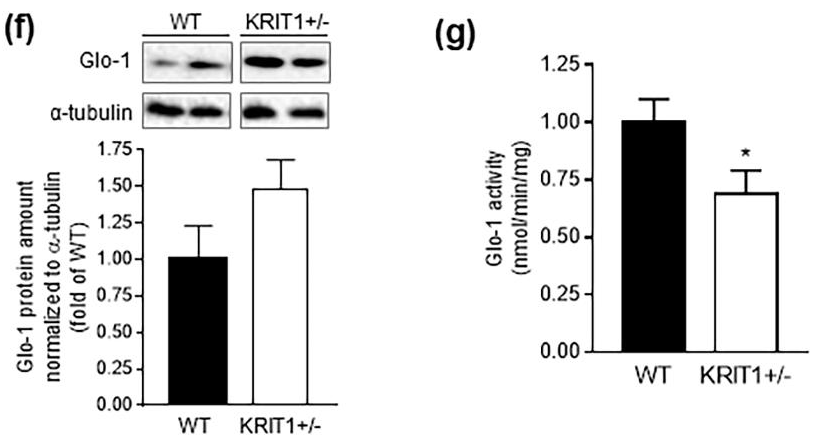
Figure 6. Heterozygous loss of KRIT1 in mice altered AGE accumulation and expression of AGE receptors and detoxifying systems in the liver. ( a , b ) Concentrations of two major types of AGEs, pentosidine ( a ) and N ε -carboxymethyl-lysine ( b ), quantified by ultraperformance liquid chromatography-tandem mass spectrometry (UPLC-MS) analysis of liver homogenates from WT and KRIT1 +/ − mice. ( c – e ) Representative Western blots showing the upregulation of pro-inflammatory AGE receptors, such as the receptor for AGE (RAGE) ( c ) and galectin-3 (Gal-3) ( d ), the downregula- tion of the anti-inflammatory receptor AGE-receptor-1 (AGE-R1) ( e ), and the upregulation of the AGE detoxifying enzyme glyoxalase-1 (Glo-1) ( f ) in the liver of KRIT1 +/ − vs. WT mice. The histograms represent the densitometric quantification of protein bands of 7 mice per group normalized to the corresponding loading control ( α -tubulin). ( g ) Enzymatic activity of Glo-1 in liver homogenates from WT and KRIT1 +/ − mice, determined spectrophotometrically by measuring the increased absorbance at 240 nm due to the catalyzed formation of S-D-lactoylglutathione from methylglyoxal (MG)-GSH hemithioacetal adducts. Data are means ± SEM of 7 mice per group and are presented as the fold change in Glo-1 enzymatic activity relative to the WT control. * p < 0.05; ** p < 0.005; *** p < 0.001 vs. WT.